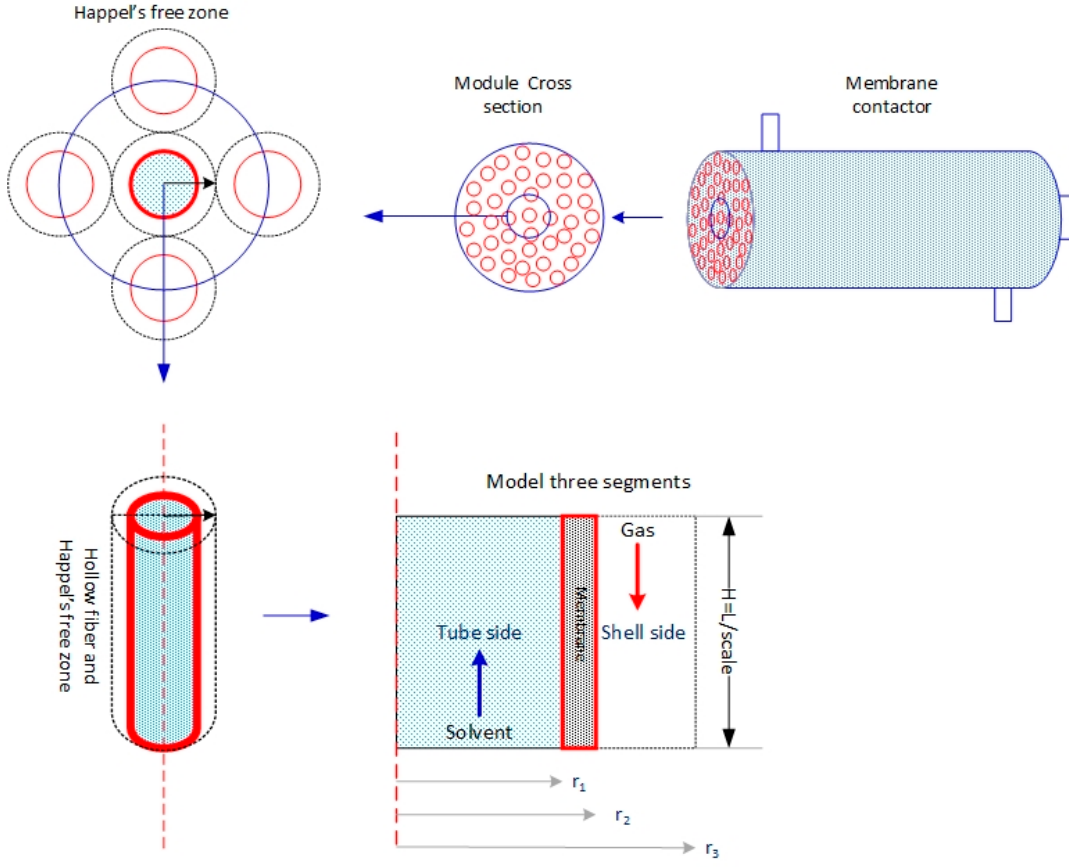
Figure 1. Simplified geometry of membrane module based on Happel’s free surface method.